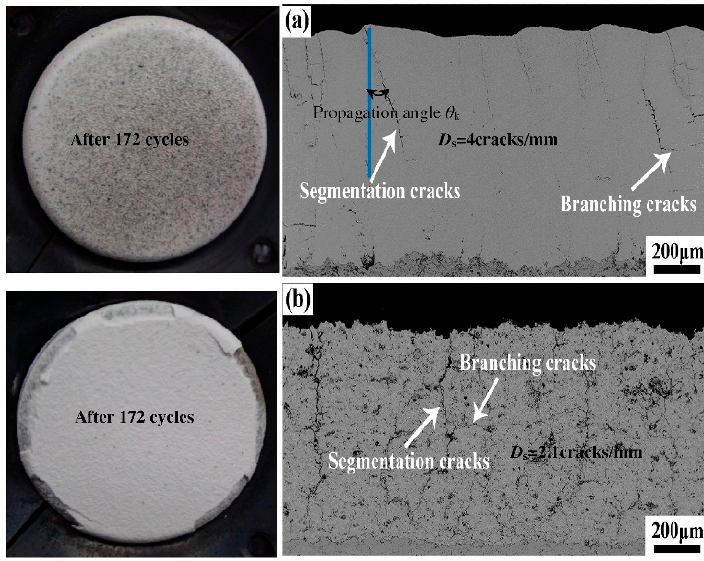
Figure 27. Burner rig test results for TTBCs with segmentation crack densities of ( a ) 4/mm and ( b ) 2.1/mm [158] .